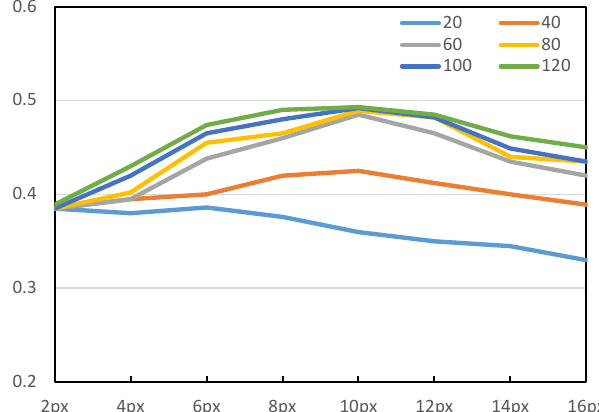
Figure 7. Evaluation of our proposal with a varying radius of projection of interest (POI) and different sampled correspondences. A horizontal axis denotes the radius of POI in pixels. The vertical axis denotes the fraction of correctly estimated scenes under the 2D reprojection error